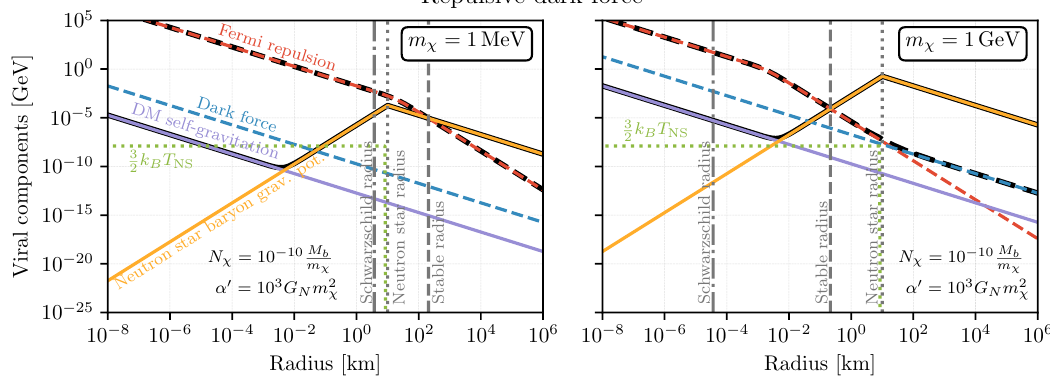
Figure 3 . Visualization of the di(cid:11)erent contributions to the virial equation, eq. (3.10), as a function of the radius for two di(cid:11)erent choices of the DM mass. We plot the absolute values of the respective contributions, and indicate attractive (repulsive) forces as solid (dashed) lines. The black solid (black dashed) line correspond to the sum of all attractive (repulsive) forces. The solution to eq. (3.10), i.e. the intersection of the black solid and black dashed lines, is highlighted by a vertical dashed